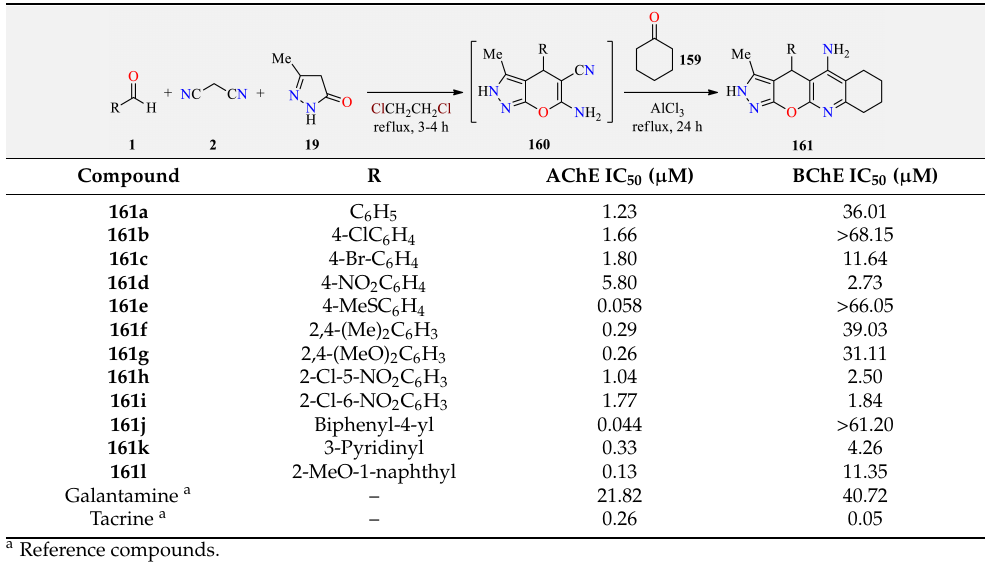
Table 52. One-pot four-component synthesis and in vitro anticholinesterase activity of new tacrine- pyranopyrazole analogues 161